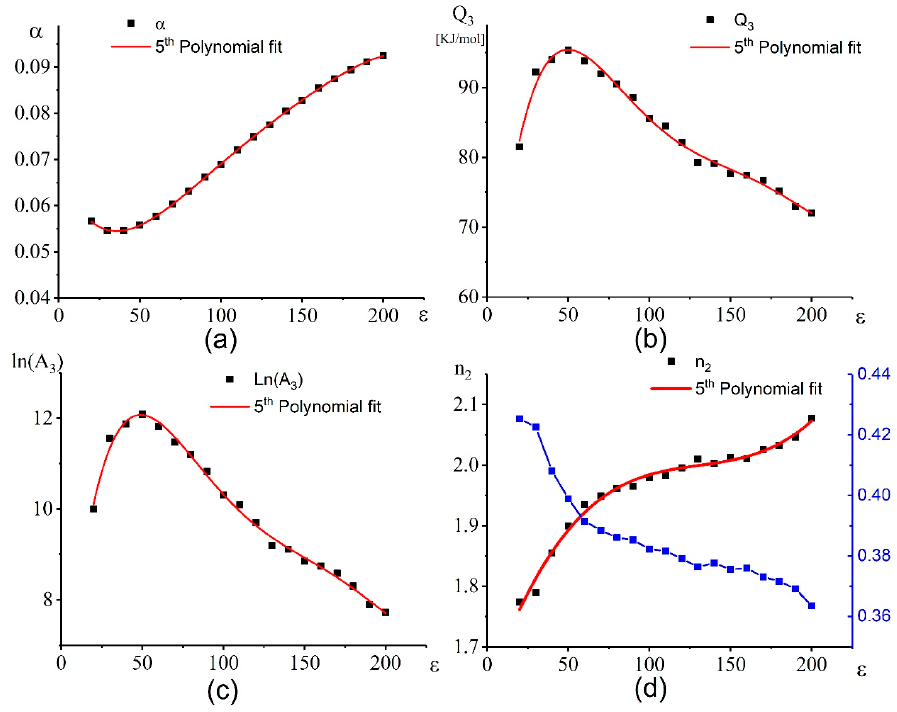
Figure 6. Dependence of the ( a ) α , ( b ) Q 3 , ( c ) ln(A 3 ), and ( d ) n 2 on strain. Based on the correlation coefficient (R), the most appropriate polynomial order is the 5th order.